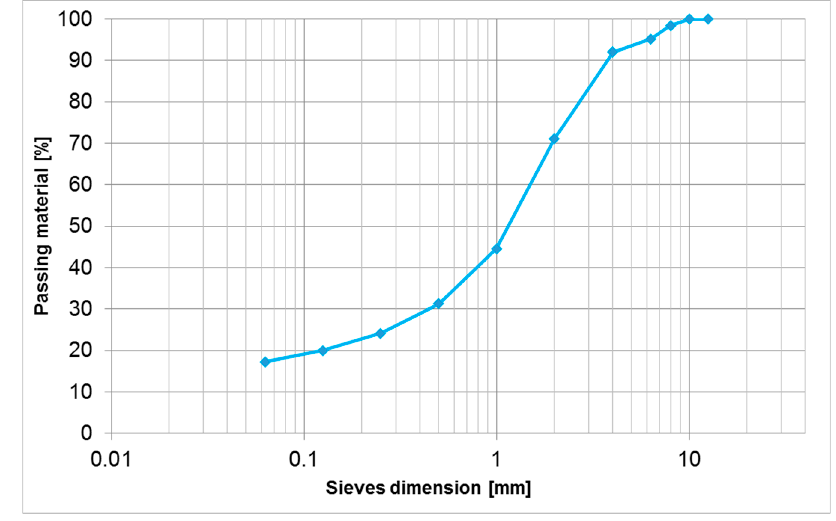
Figure 1. Grading distribution for Paving Block Aggregates (PBA).